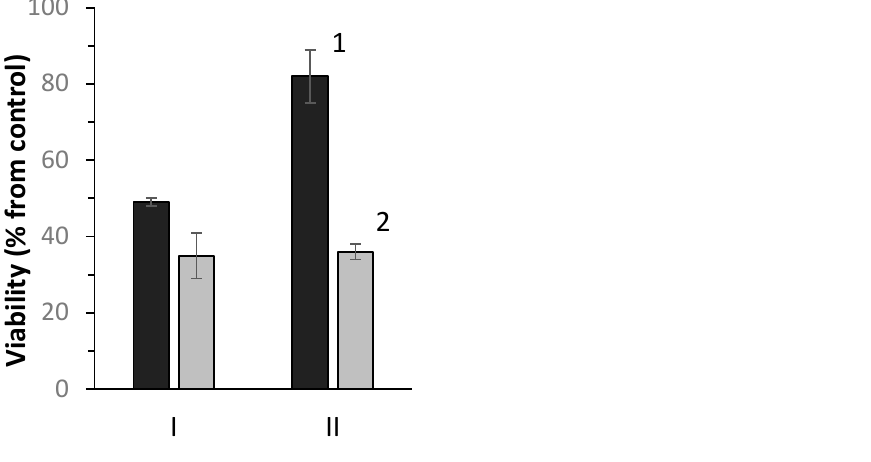
Figure 10. Antimicrobial activity of AuNPs synthesized by R. erythropolis IEGM 766 (I) and R. ruber IEGM 1135 (II) against M. luteus IEGM 401 (1) and E. coli ATCC 25922 (2).